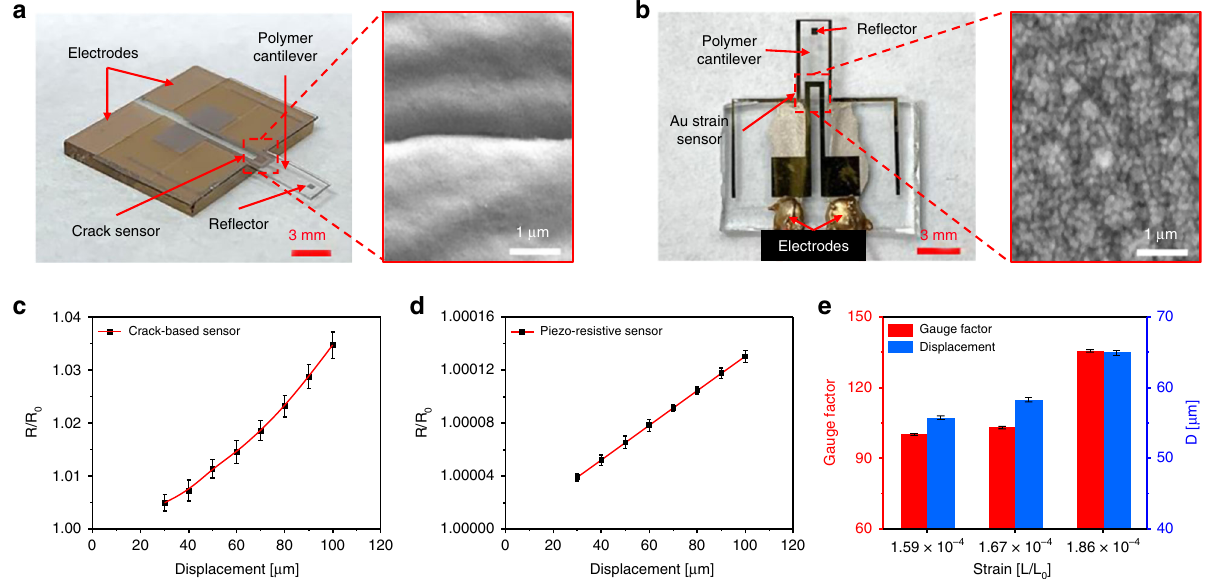
Fig. 3 Change in resistance of the crack sensor and conventional strain sensor at different displacement. a , b Optical, and SEM images of the PDMS- encapsulated crack sensor and Au strain sensor integrated on a silicone rubber cantilever. c , d Change in sensor resistance ratio of the proposed crack sensor and piezo-resistive sensor as a function of displacement with the ramp of 10 µ m. e The averaged gauge factor of the crack sensor at the different applied strain. c – e Error bars are mean ± s.d. ( n = 5). D represents